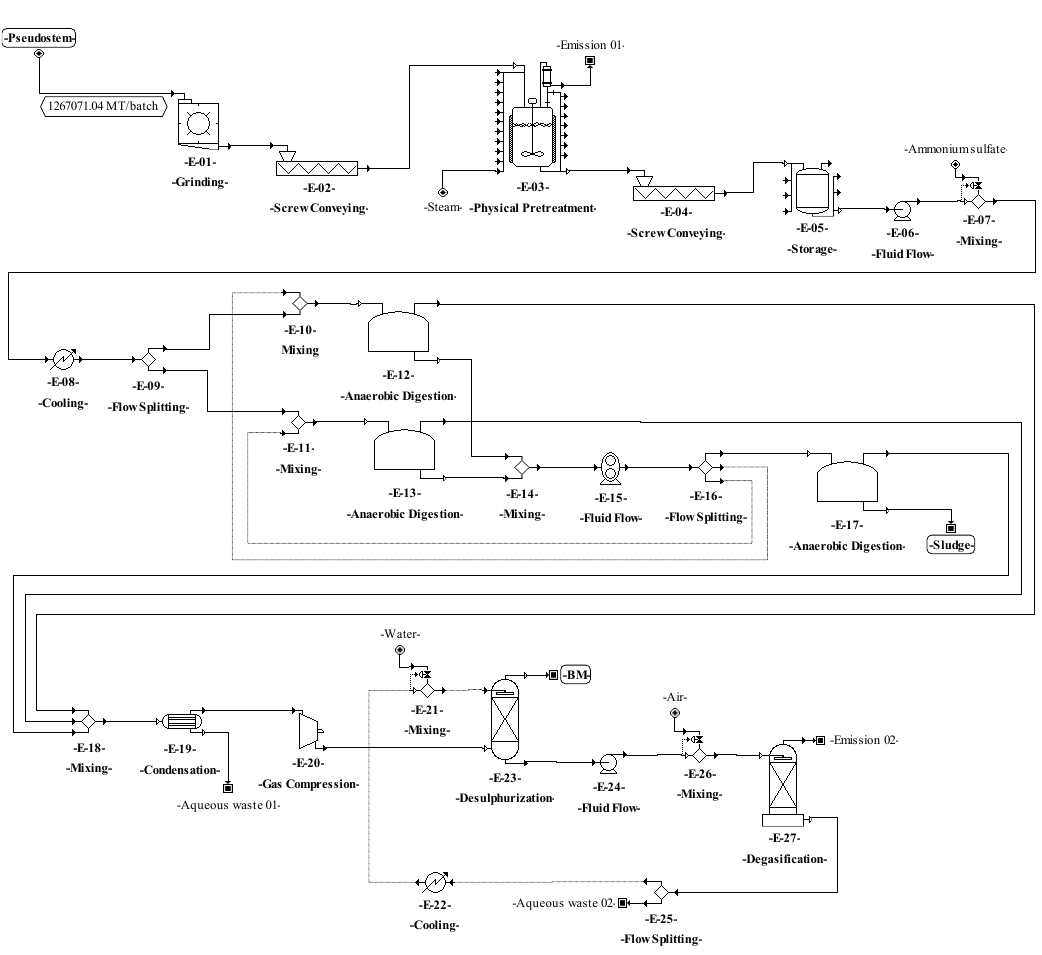
Figure 7. Process flowsheet of biomethane (BM) production from plantain pseudostems.